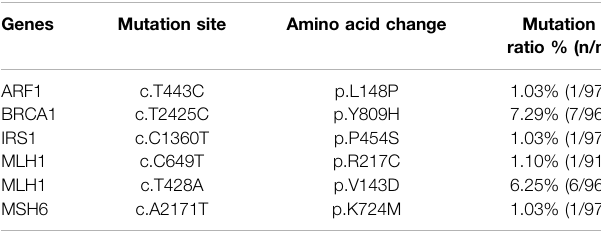
TABLE4| ValidationofSNVsusingSNaPshotSNPassayinanindependentGIST cohort (n (cid:2) 97).